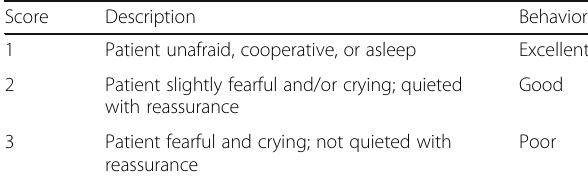
Table 3 Child-Parent Separation Scale (Patel et al., 2015)